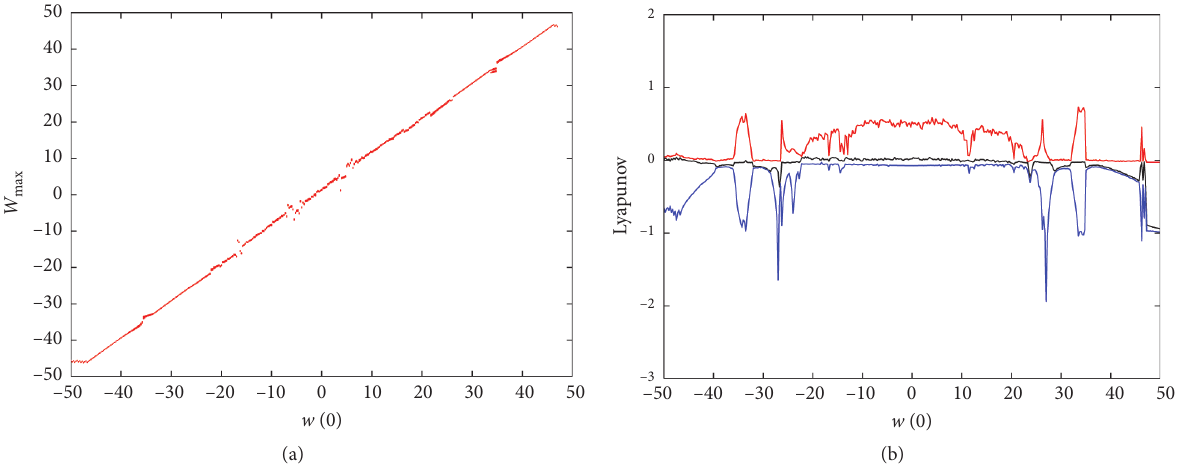
Figure 7: (a) Bifurcation diagram of the state variable w and (b) Lyapunov spectrum with respect to memristor initial condition w ( 0 ) .